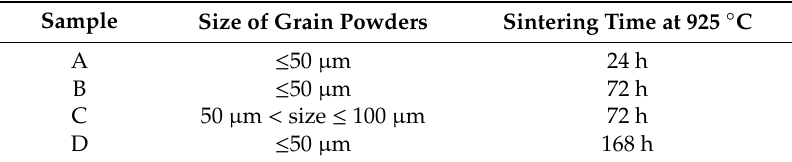
Table 1. Description of sintered